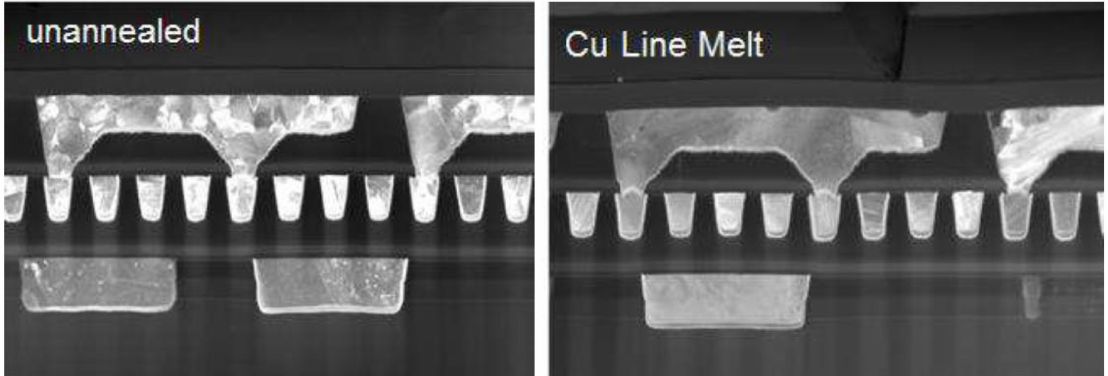
Figure 14. Examples of Cu BEOL lines prior to and after Cu melt LA. Reprinted with permission from Ref. [76]. 2018, The Electrochemical Society